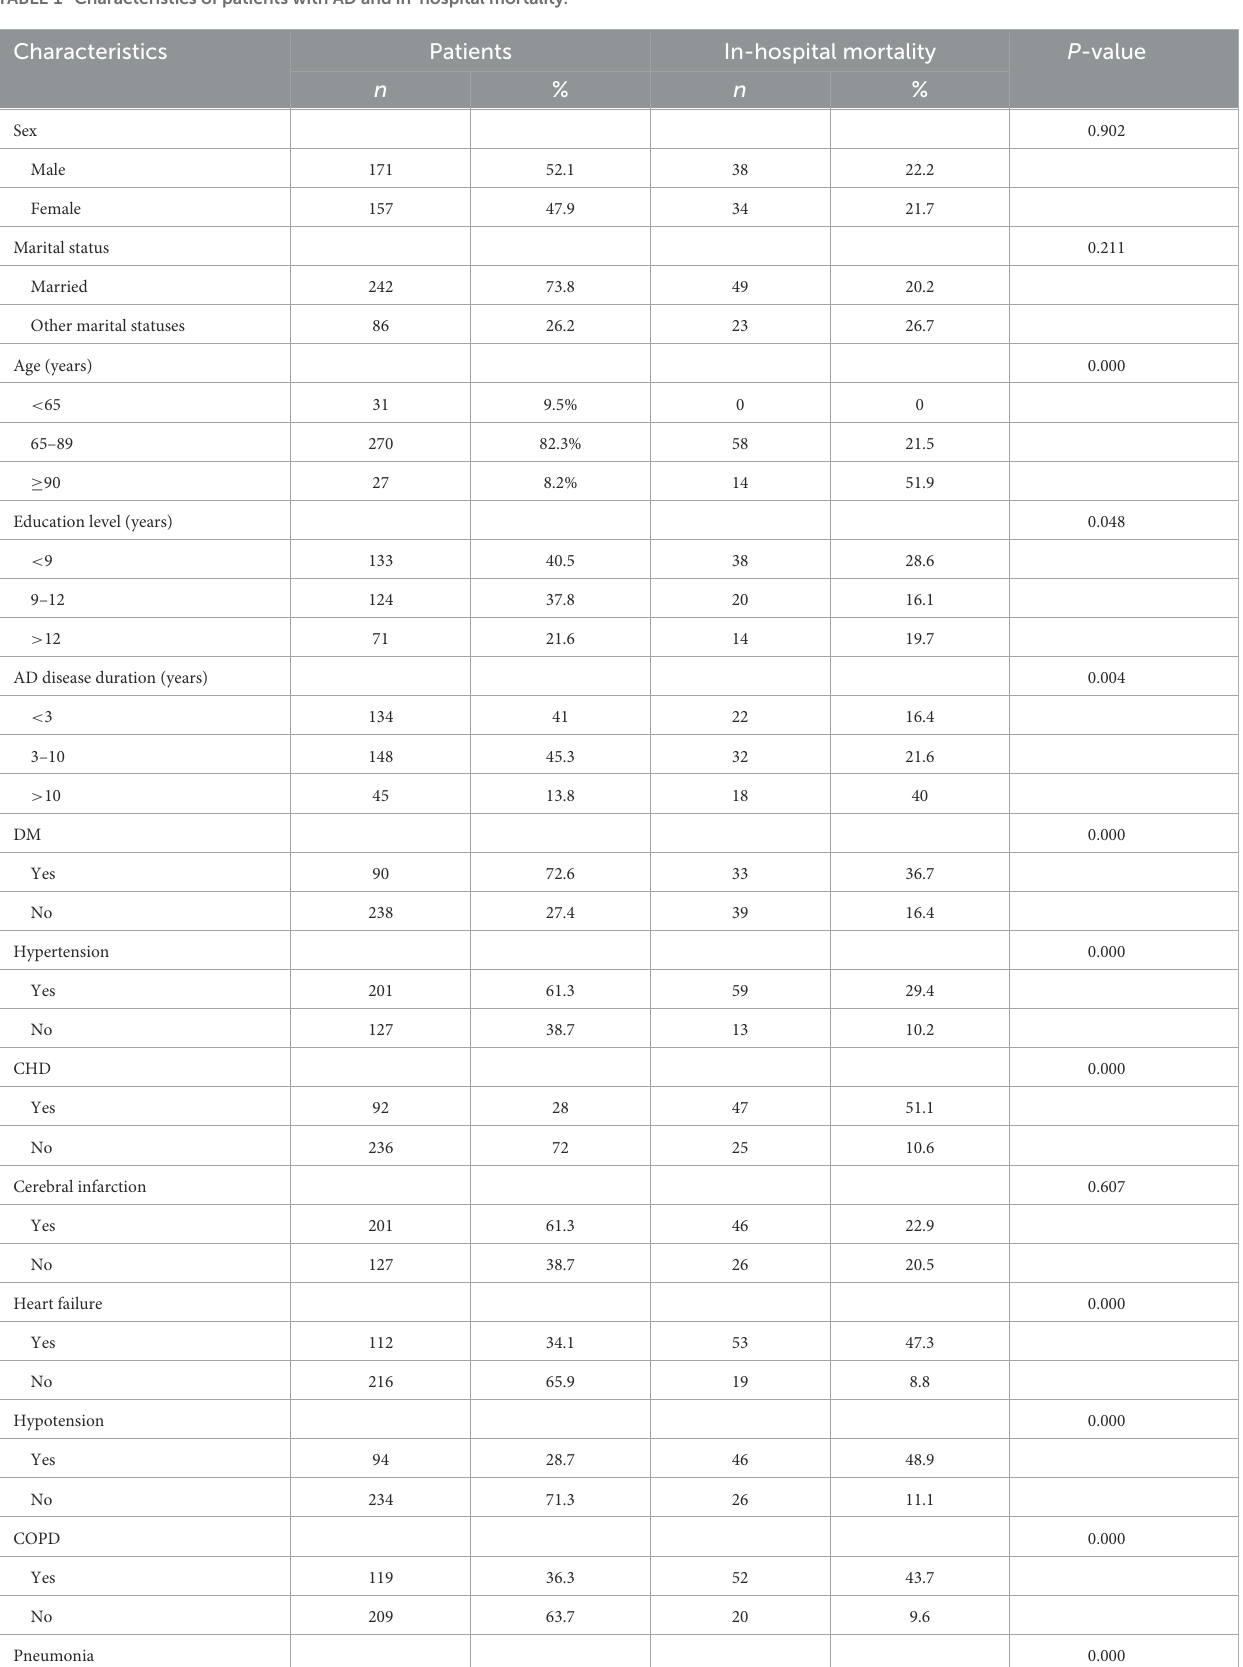
TABLE 1 Characteristics of patients with AD and in-hospital mortality.